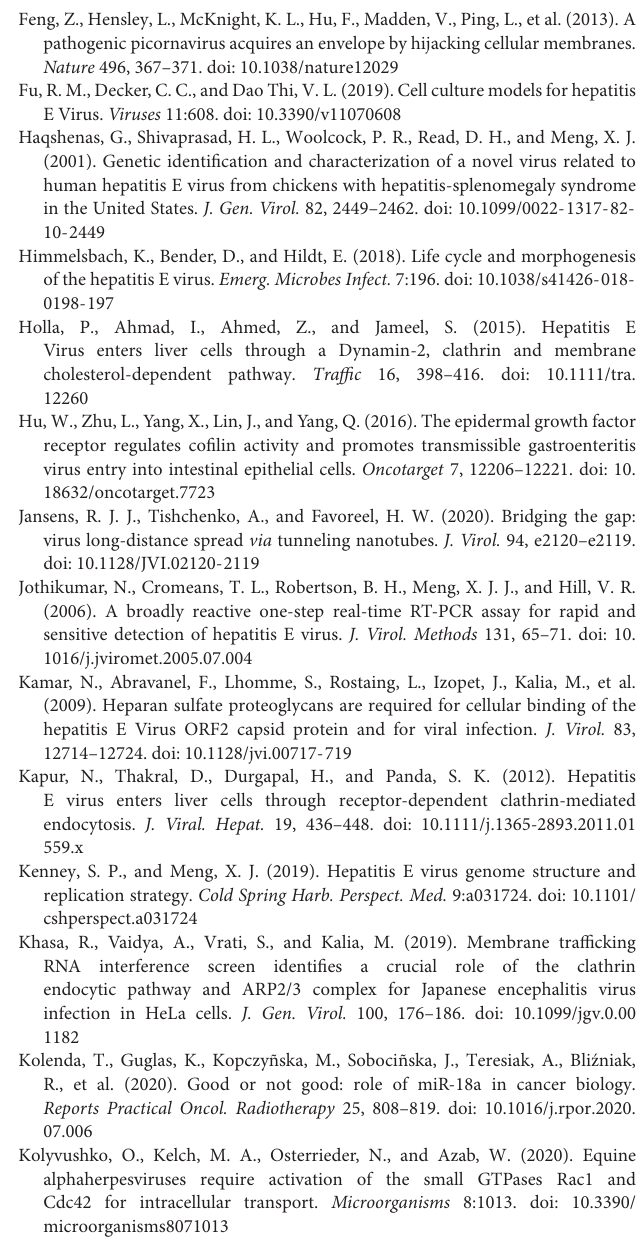
(B) , PAK1 (C) , MYLK (D) , non-myosin heavy chain (NMHC) (E) and Arp3 (F) in LMH OATP1A2 cells transfected with different concentrations [10, 20, and 40 nM (or 30 nM)] of siRhoA, siRAC1, siPAK1, siMYLK, siNMHC and siArp3, respectively. Supplementary Figure 6 | Amino acid alignments of CDC42 from different species. The Clustal W module of the MegAlign program of Lasergene 7.1 (DNASTAR Inc., MI, United States) was used. Supplementary Figure 7 | Identification of HEV virions and cytotoxicity analysis of Rho family GTPases inhibitors in HepG2/C3A cells. Iodixanol gradient of non-enveloped HEV virions (A) and quasi-enveloped HEV virions (B) . Iodixanol gradients of 10–50% w/v of HEV virions. HEV RNA infraction was determined by qPCR. Cytotoxicity analysis of Rho family GTPases inhibitors in HepG2/C3A cells (C,D)